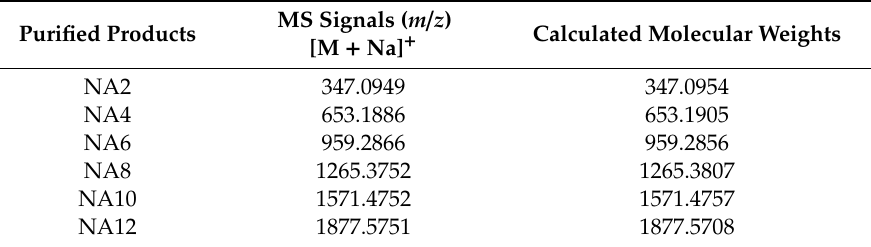
Figure 6. FTIR spectrum of NAOS.